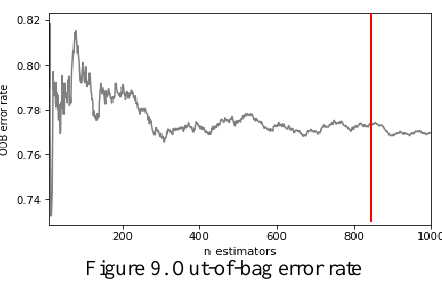
Figure 9. Out-of-bag error rate